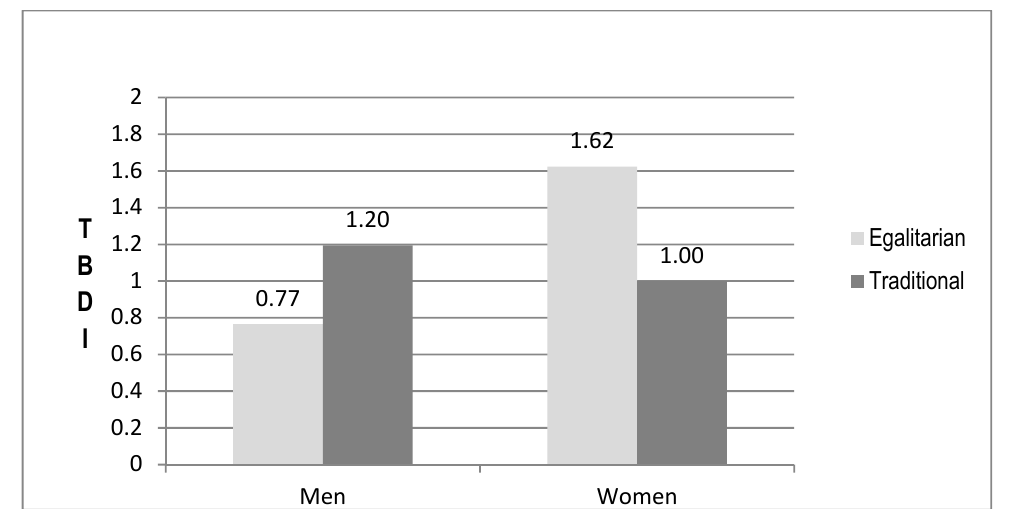
Figure 1. English by Gender Explaining Distress.